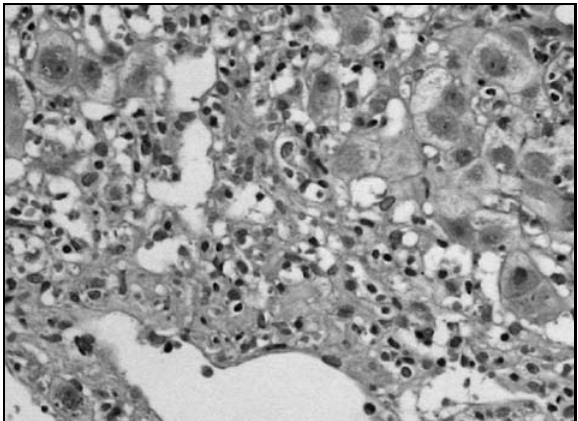
Figura 7 – Zona central com dilatação da veia, peri-flebite, circundada por hepatócitos que exibem balonização (H & E,